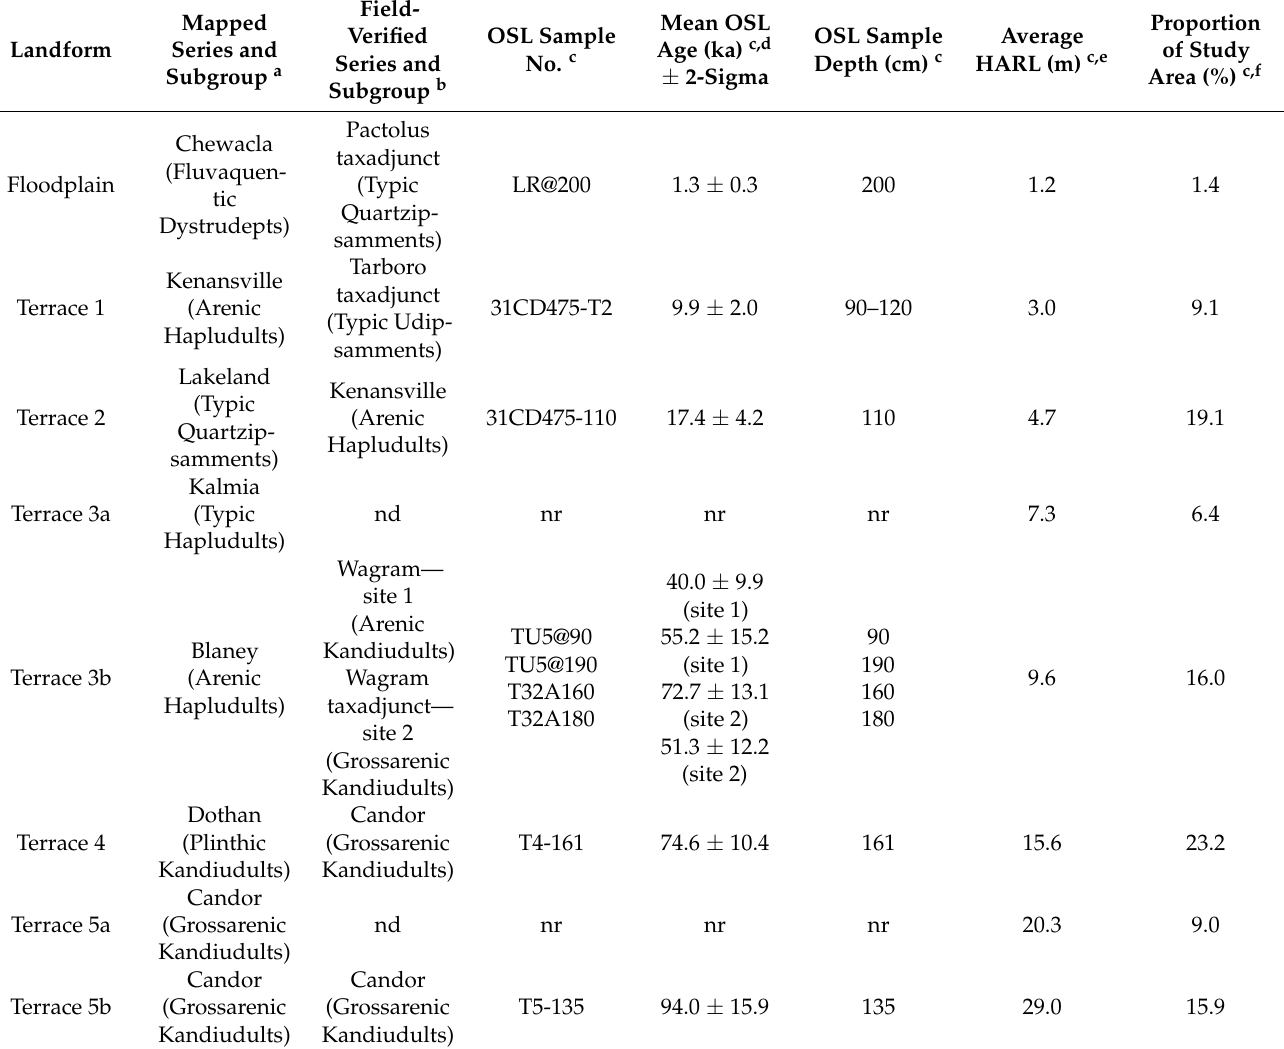
Table 1. Soils, ages, and extents of terraces, adapted from Table 1 of Suther and Leigh [33] and Tables 1 and 2 of Suther et al.